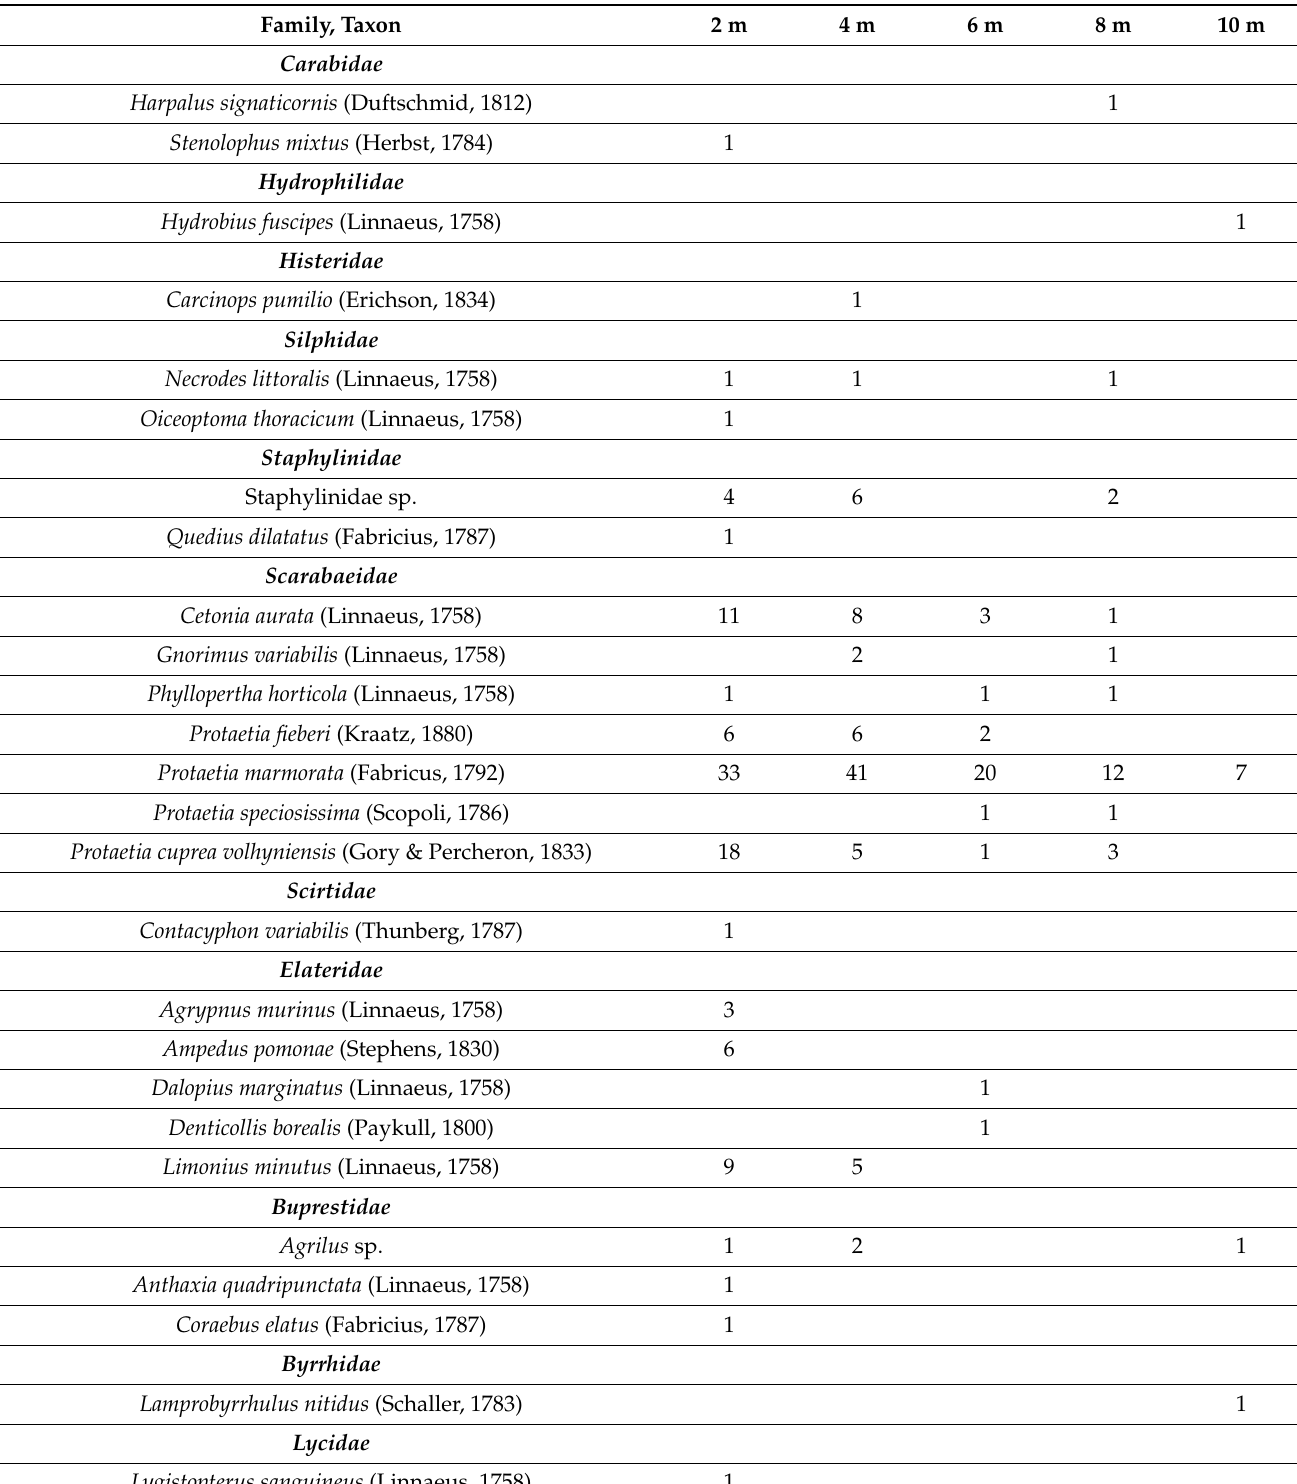
Table 1. Species diversity and abundance of Coleoptera were collected using fermental traps at different heights on the territory of the Mordovia State Nature